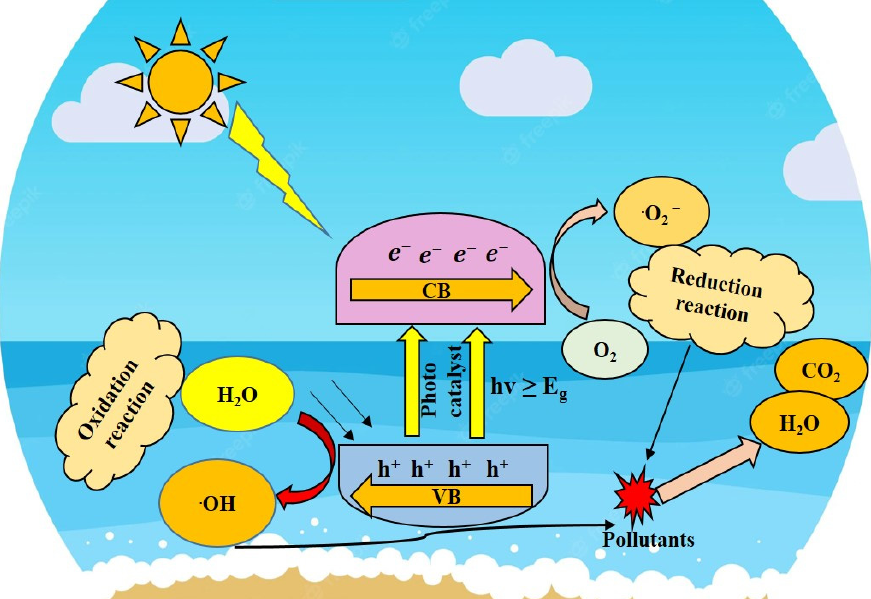
Figure 2. Schematic representation of the mechanism of photocatalytic degradation of pollutants.